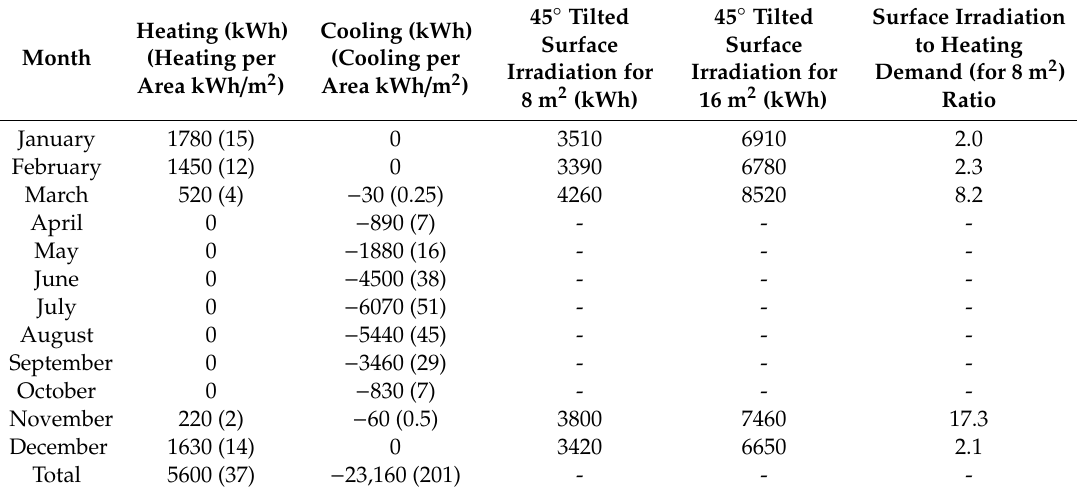
Table 1. Heating and Cooling loads per month.